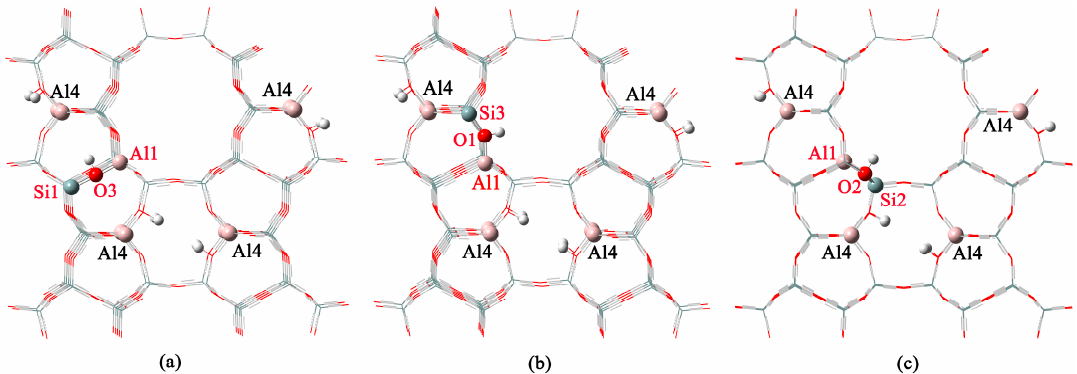
Figure 4. The distribution of Al atoms if the content of Al is so high that all T4 sites are substituted by Al atoms.